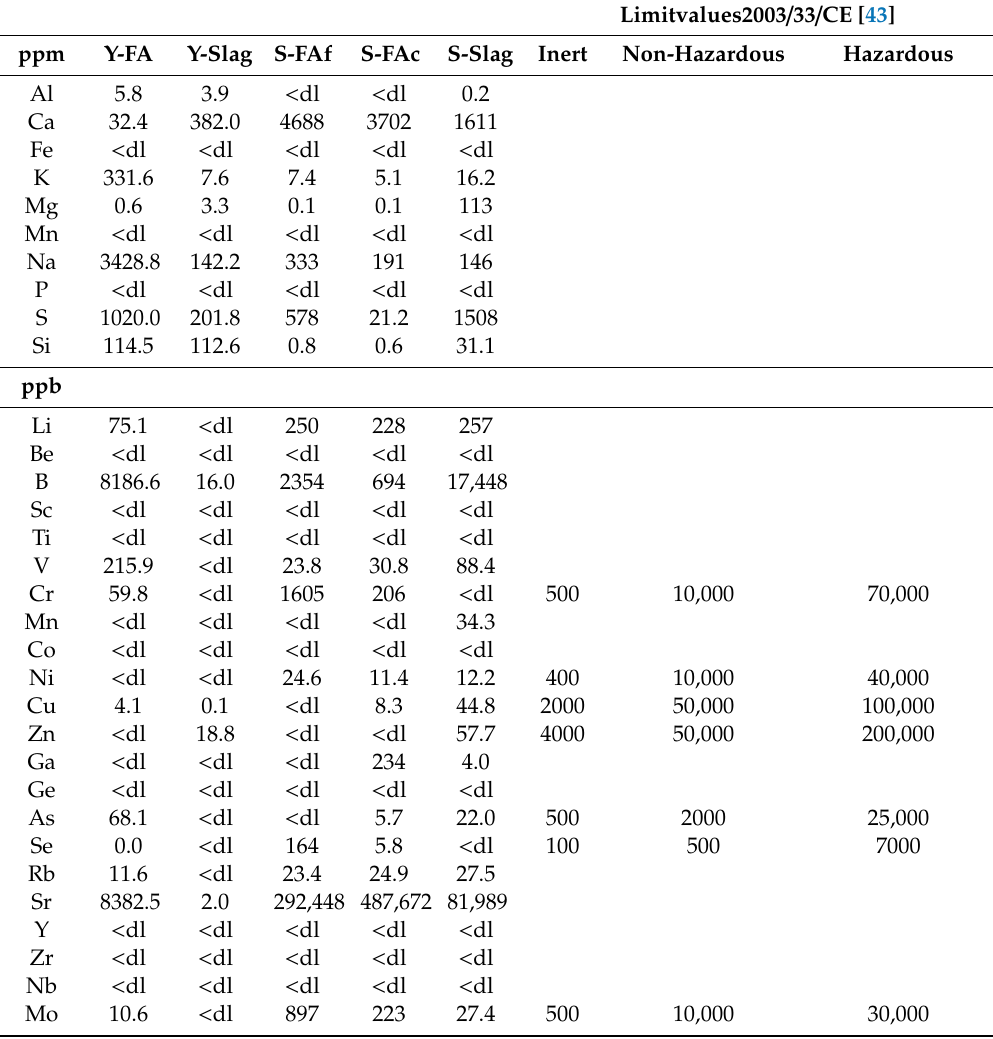
Table 6. Element concentrations of fly ash and slag leachates compared with EU fly ash leachates [52] and inert, non-hazardous, and hazardous limit values of some toxic elements for landfill